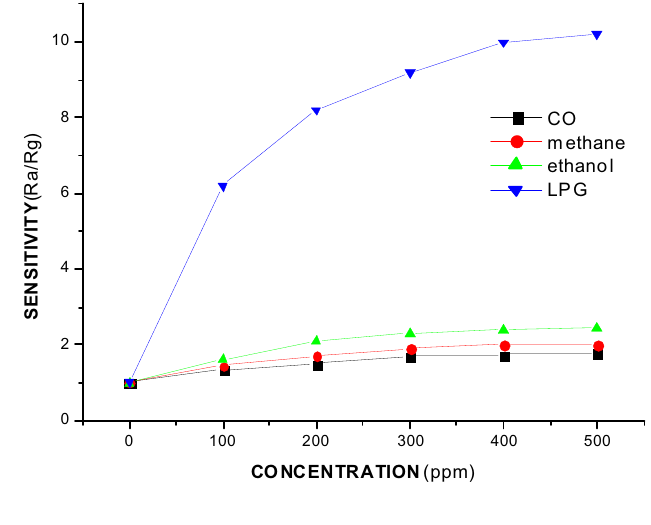
Figure 8. Sensitivity of ZnGa